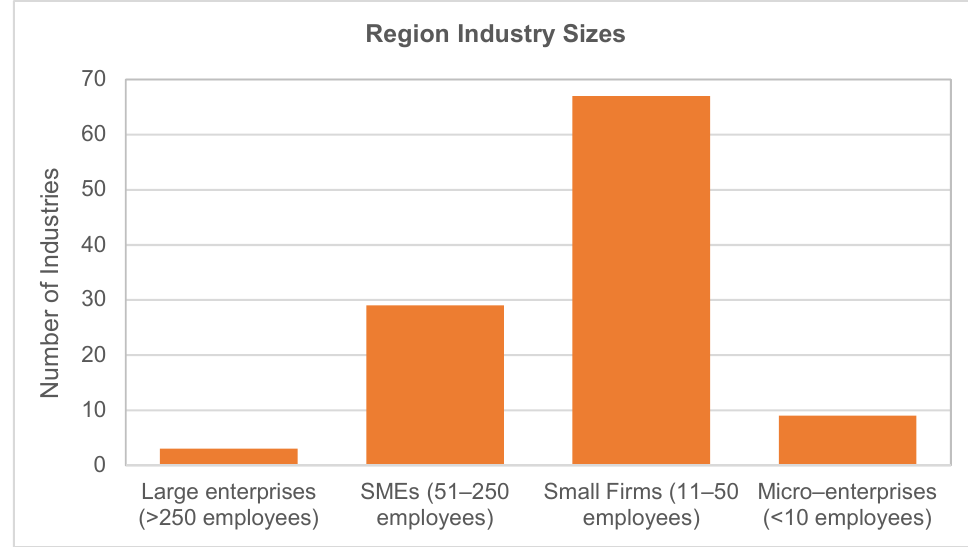
Figure 3. Industrial profile per size of the SWAN industrial ecosystem in Cyprus.